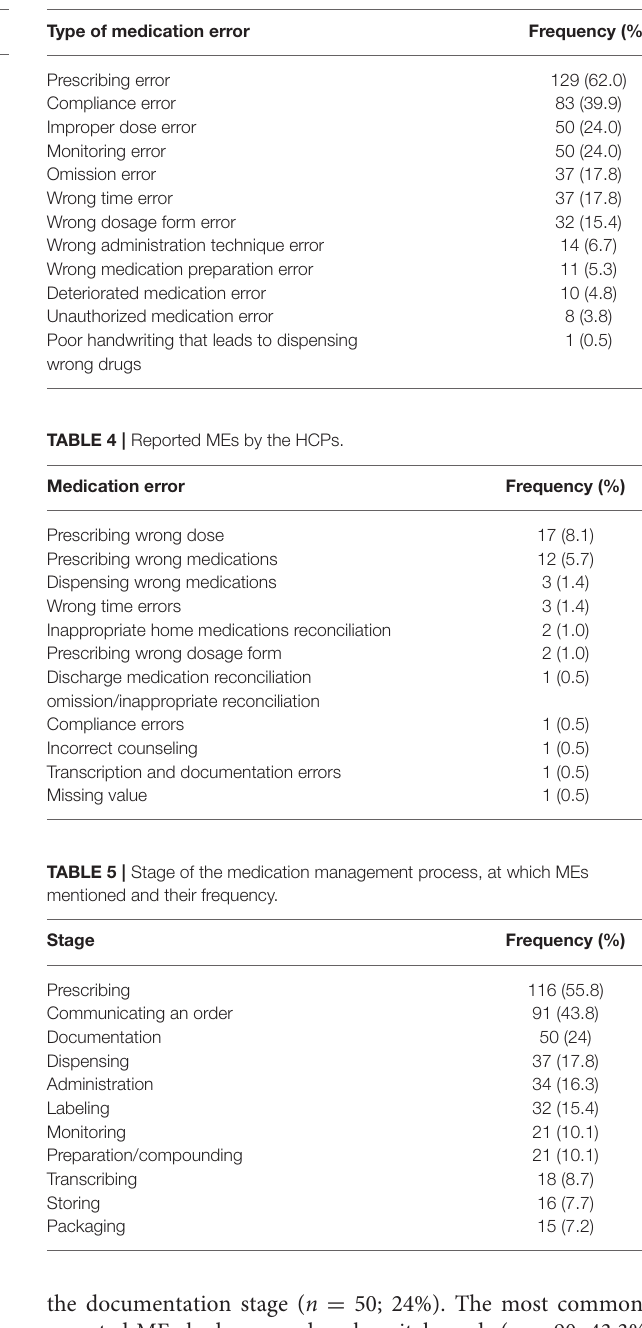
TABLE 2 | Demographic characteristics of the respondents. TABLE 3 | Types of MEs mentioned in the questionnaire and their frequency.